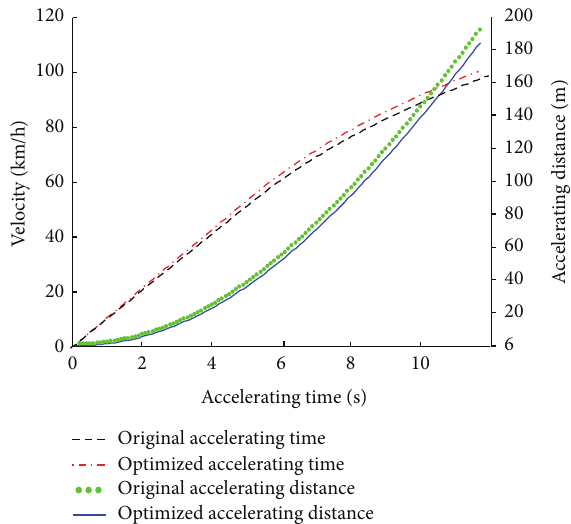
Figure 6: Simulation curve of accelerating time and distance.